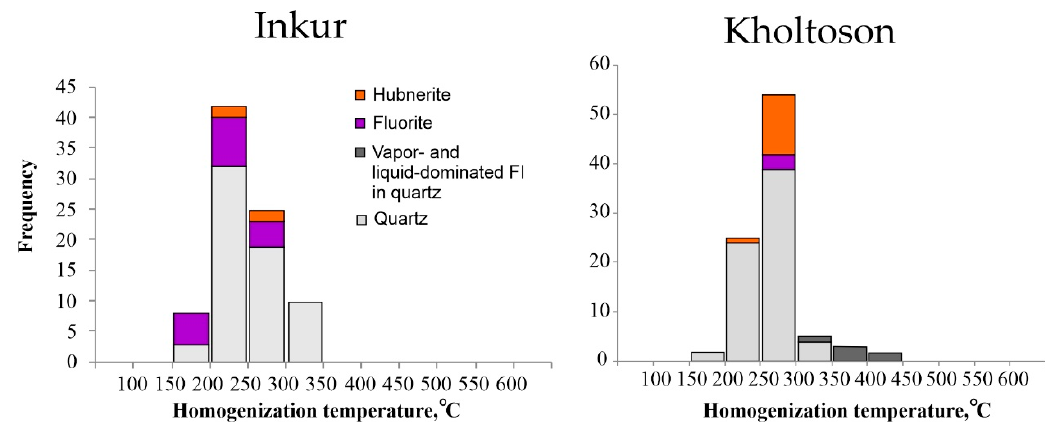
Figure 7. Homogenization temperature distribution histograms of fluid inclusions from different minerals of the Inkur and Kholtoson deposits.